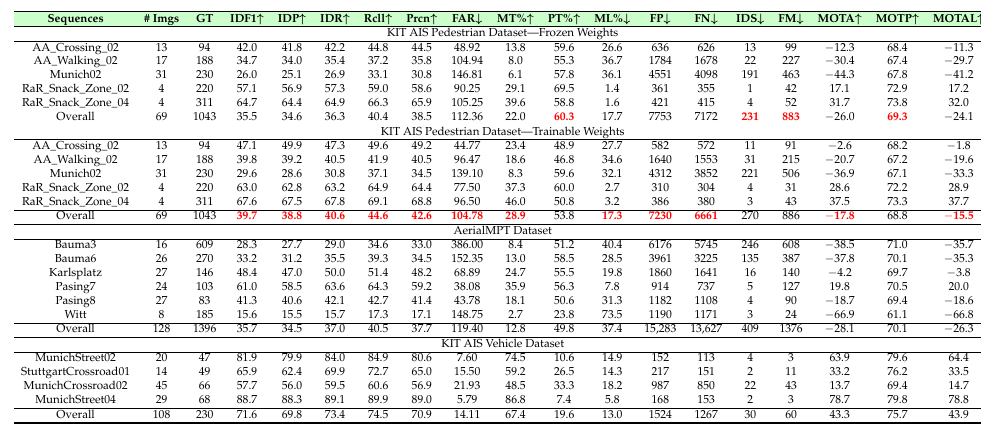
Table 12 represents the overall performances of different tracking methods on the KIT AIS and AerialMPT datasets. According to the table, AerialMPTNet LSTM